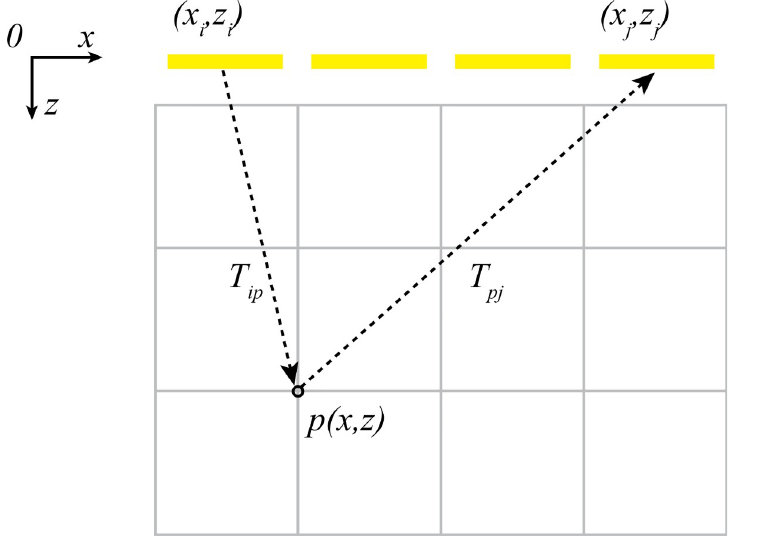
Fig 1. Total focusing method